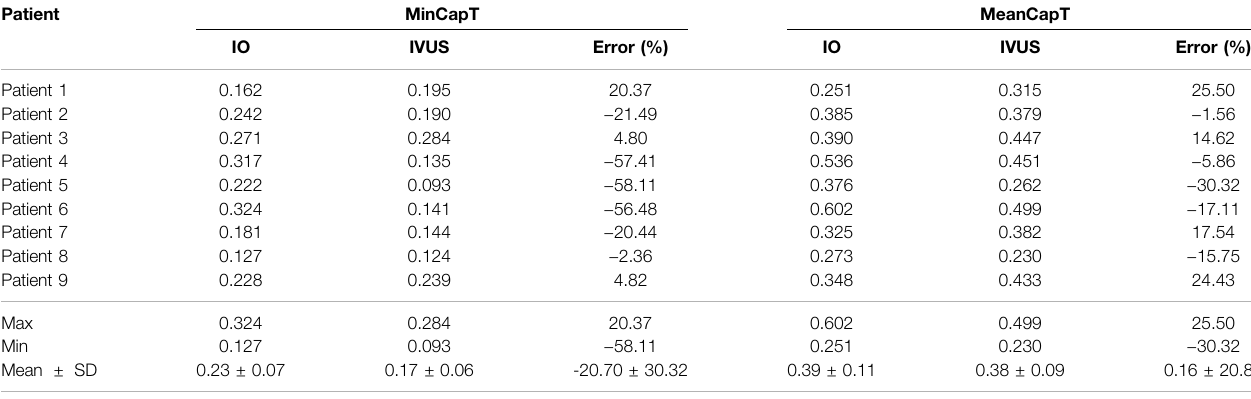
TABLE 2 | Summary of minimum and mean cap thickness from 9 patients based on 114 slices at baseline. Unit for fi brous cap thickness: mm. Patient